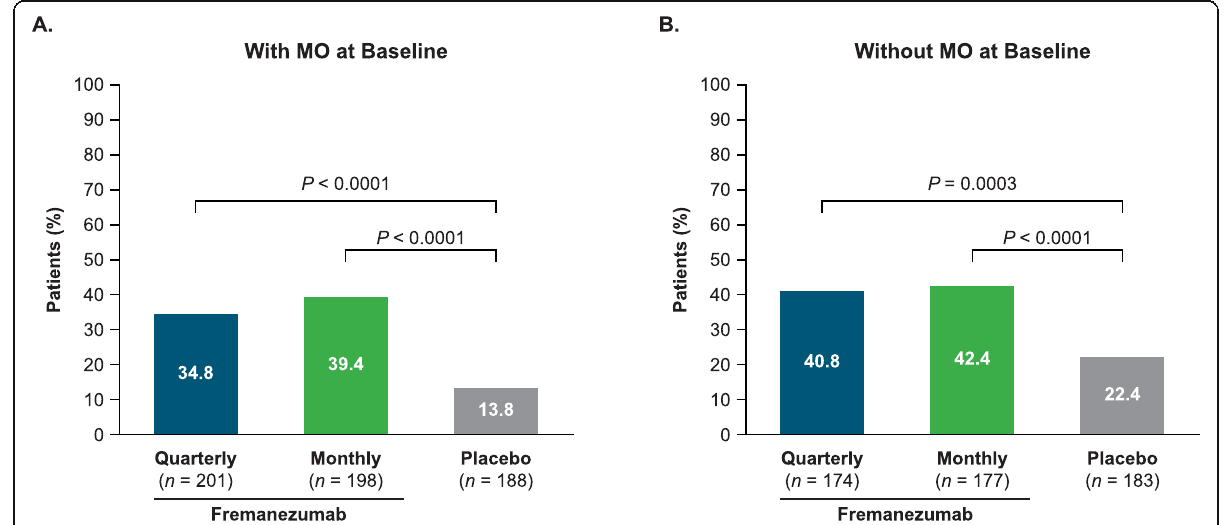
Fig. 2 Proportion of patients with CM with ≥ 50% response ( a ) with MO and ( b ) without MO. A ≥ 50% response was defined as ≥ 50% reduction from baseline in the monthly average number of headache days of at least moderate severity over 12 weeks. CM, chronic migraine; MO, medication